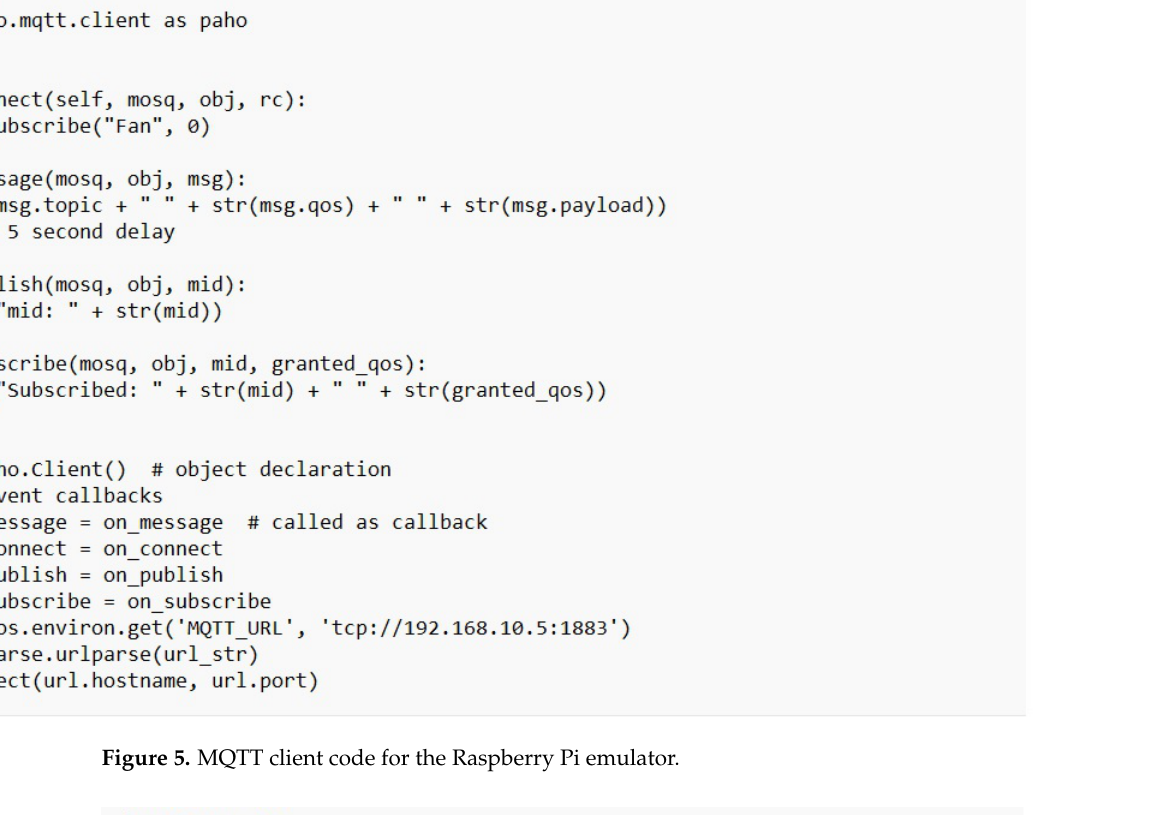
Figure 5. MQTT client code for the Raspberry Pi emulator.